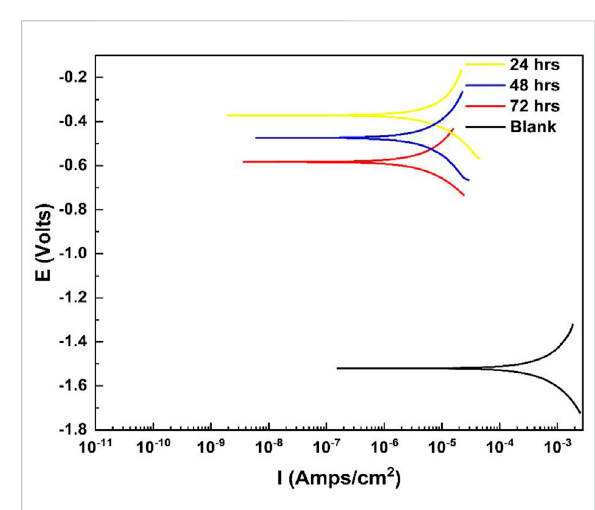
FIGURE 7 Tafel curves of the coated and bare Al alloy 6101 samples in the 0.001 M NaOH solution (pH